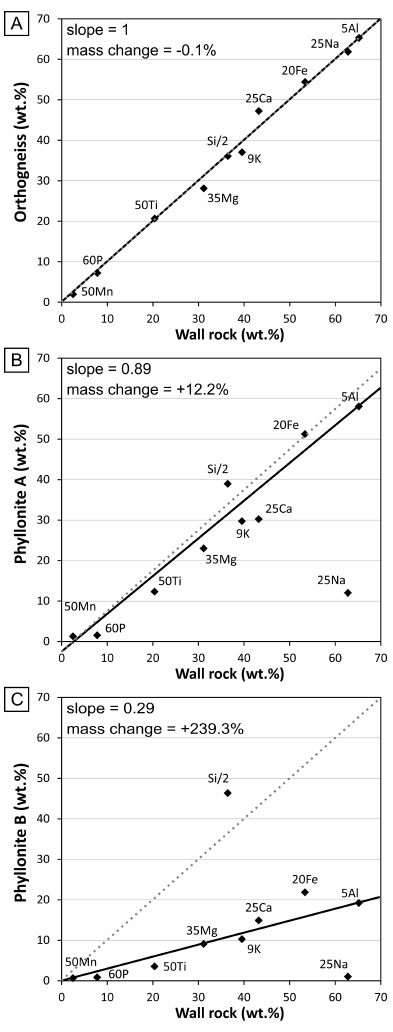
Figure 10. Isocon diagrams (Grant, 1986) showing major element concentrations for (a) orthogneiss, (b) phyllonite A and (c) phyl- lonite B plotted against the wall rock composition. The dashed line represents a situation of a zero mass change. The isocon (solid line) is constructed assuming immobile Al 2 O 3 . Elements enriched in the altered domains lie above the isocon; the elements which are de- pleted lie below. Scaling factors (shown in front of each element) have been applied to avoid data clustering. The detection error is smaller than the diameter of the data points (cf. Table